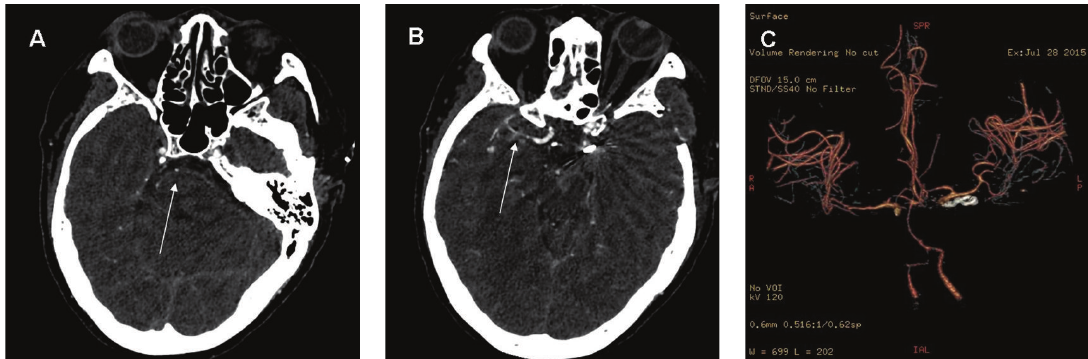
Figure 3: Postbleed day 6 CTA of the COW. CTA = computed tomographic angiography and COW = circle of Willis. (A) Axial CTA image at the level of the pons displaying severe spasm of the basilar artery (white arrow). (B) Axial CTA image at the level of the mesencephalon displaying severe spasm of the right proximal middle cerebral artery (white arrow). (C) Three-dimensional reconstruction of the CTA displaying the COW. Of note is the severe spasm of the basilar artery trunk and the right middle cerebral artery and bilateral proximal anterior cerebral arteries.